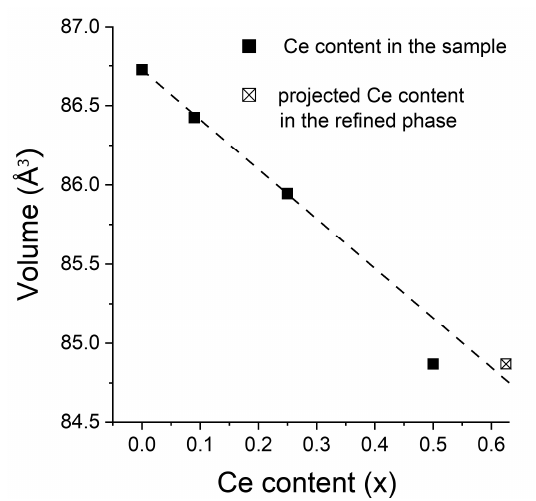
Figure 2. Dependence of the unit cell volume with cerium content (x) in La 1-x Ce x Ni 5 . The cerium content is given as a cerium content in the sample. The one different point on the graph represents the projected close to real cerium content in the refined phase.